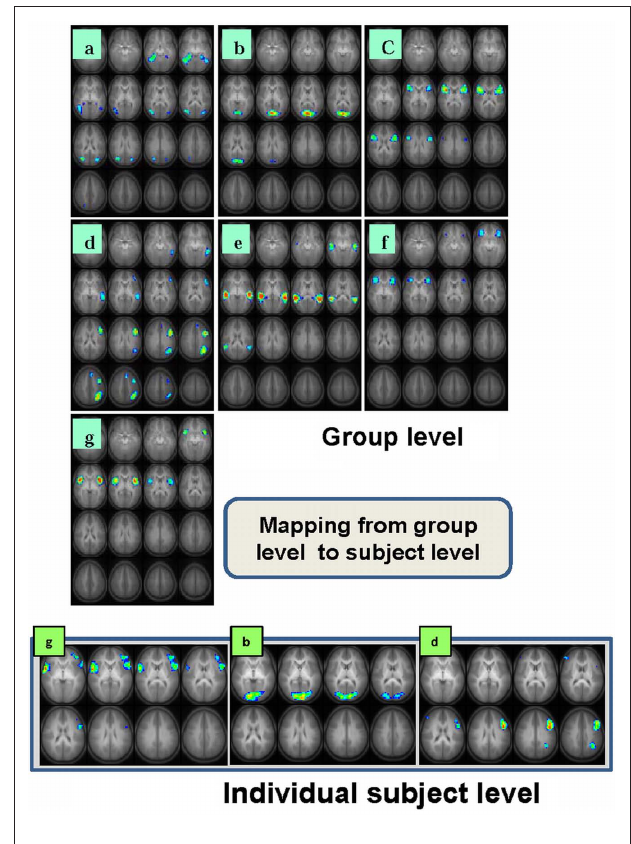
FIguRe 1 | Seven task-related spatial independent components maps are shown in panels a-g. These ICs are computed using group ICA analysis of 336 children ages 5–18 performing the task of covert verb generation (Karunanayaka et al., 2010). Slice range: Z = −25 to +50 mm (Talairach coordinates). Three corresponding single subject IC maps are shown at bottom ( g, b, d ). These individual spatial maps and the associated time courses ( Figure 2B ) are estimated using a back propagation algorithm following the ICA decomposition at the group level and used in the subsequent LSEM analysis. All images are in